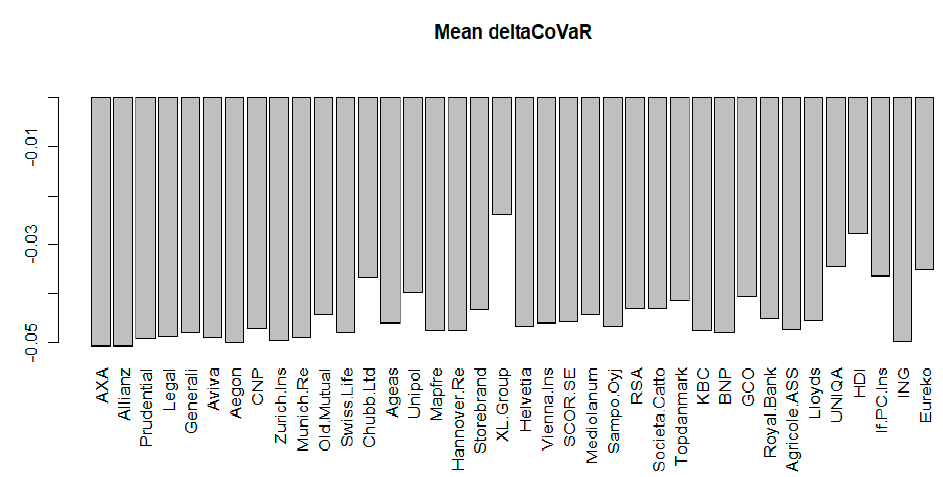
Figure 16. Mean deltaCoVaR for each insurer. Source: Own study.